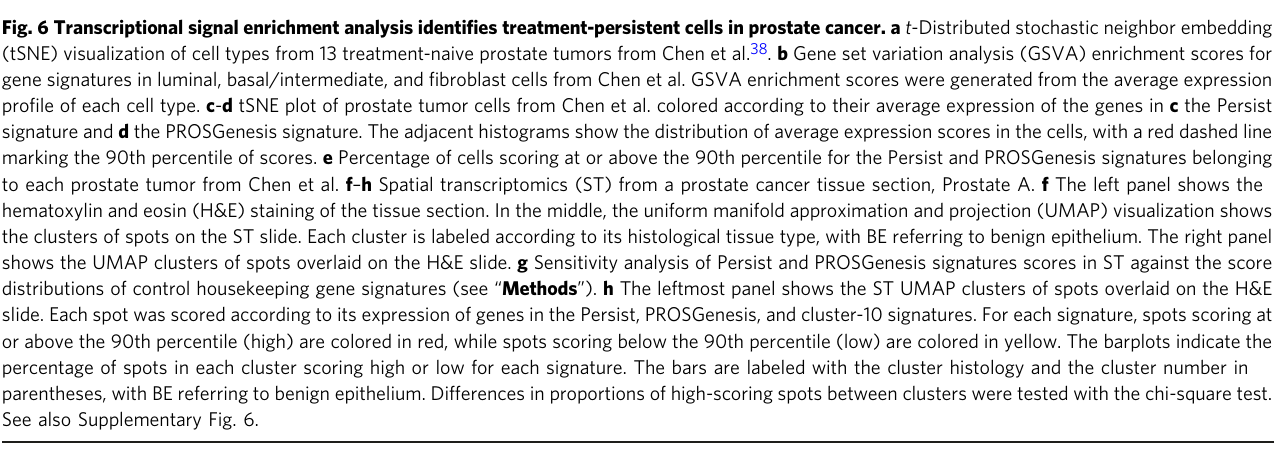
Fig. 6 Transcriptional signal enrichment analysis identi fi es treatment-persistent cells in prostate cancer. a t -Distributed stochastic neighbor embedding (tSNE) visualization of cell types from 13 treatment-naive prostate tumors from Chen et al. 38 . b Gene set variation analysis (GSVA) enrichment scores for gene signatures in luminal, basal/intermediate, and fi broblast cells from Chen et al. GSVA enrichment scores were generated from the average expression pro fi le of each cell type. c - d tSNE plot of prostate tumor cells from Chen et al. colored according to their average expression of the genes in c the Persist signature and d the PROSGenesis signature. The adjacent histograms show the distribution of average expression scores in the cells, with a red dashed line marking the 90th percentile of scores. e Percentage of cells scoring at or above the 90th percentile for the Persist and PROSGenesis signatures belonging to each prostate tumor from Chen et al. f – h Spatial transcriptomics (ST) from a prostate cancer tissue section, Prostate A. f The left panel shows the hematoxylin and eosin (H&E) staining of the tissue section. In the middle, the uniform manifold approximation and projection (UMAP) visualization shows the clusters of spots on the ST slide. Each cluster is labeled according to its histological tissue type, with BE referring to benign epithelium. The right panel shows the UMAP clusters of spots overlaid on the H&E slide. g Sensitivity analysis of Persist and PROSGenesis signatures scores in ST against the score distributions of control housekeeping gene signatures (see “ Methods ” ). h The leftmost panel shows the ST UMAP clusters of spots overlaid on the H&E slide. Each spot was scored according to its expression of genes in the Persist, PROSGenesis, and cluster-10 signatures. For each signature, spots scoring at or above the 90th percentile (high) are colored in red, while spots scoring below the 90th percentile (low) are colored in yellow. The barplots indicate the percentage of spots in each cluster scoring high or low for each signature. The bars are labeled with the cluster histology and the cluster number in parentheses, with BE referring to benign epithelium. Differences in proportions of high-scoring spots between clusters were tested with the chi-square test. See also Supplementary